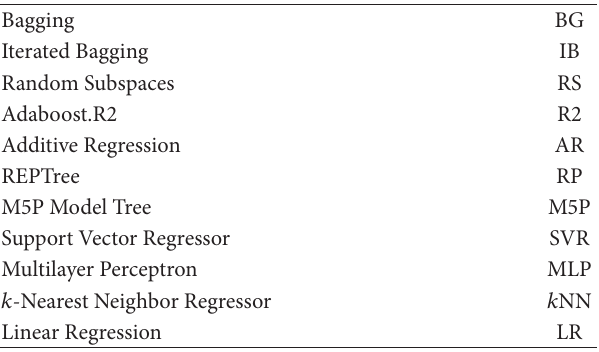
Table 6: Methods